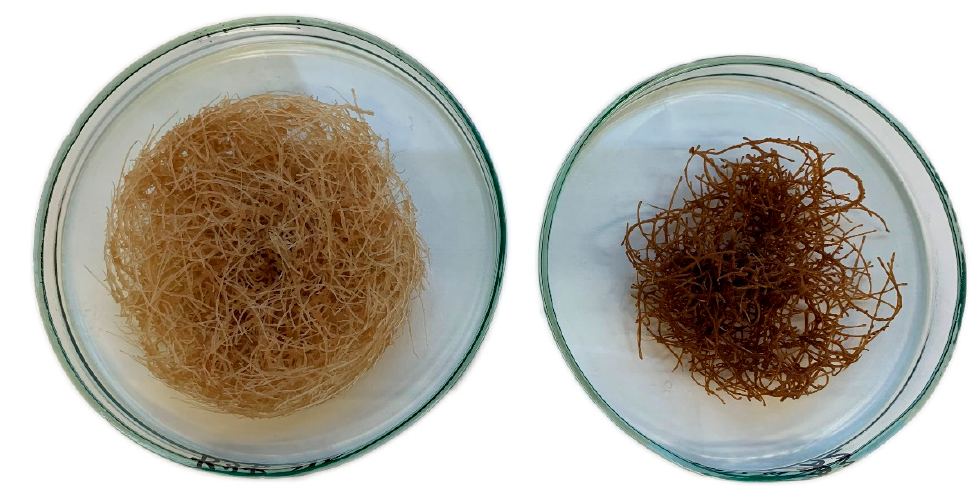
Figure 2. The morphological changes induced by jasmonic acid in C. officinalis hairy roots after 21 days of treatment. ( left ) control, ( right ) JA elicited sample.